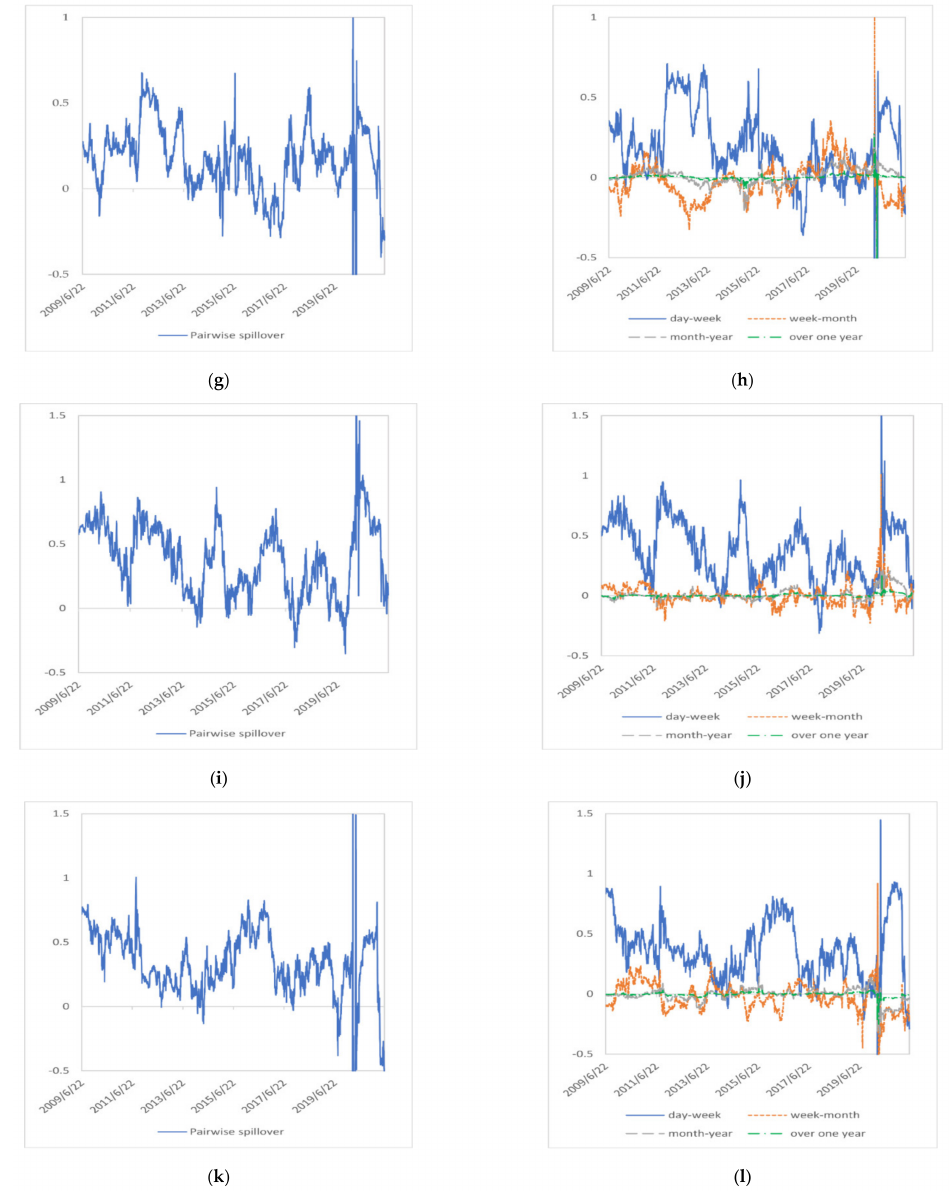
Figure 12. Pairwise connectedness between NEX and other variables in price return system. ( a ) pair- wise connectedness between NEX and MSCI. ( b ) frequency decomposition of pairwise connectedness between NEX and MSCI. ( c ) pairwise connectedness between NEX and PSE. ( d ) frequency decompo- sition of pairwise connectedness between NEX and PSE. ( e ) pairwise connectedness between NEX and WTI. ( f ) frequency decomposition of pairwise connectedness between NEX and WTI. ( g ) pairwise connectedness between NEX and Brent. ( h ) frequency decomposition of pairwise connectedness between NEX and Brent. ( i ) pairwise connectedness between NEX and EUA. ( j ) frequency decompo- sition of pairwise connectedness between NEX and EUA. ( k ) pairwise connectedness between NEX and 10YTN. ( l ) frequency decomposition of pairwise connectedness between NEX and